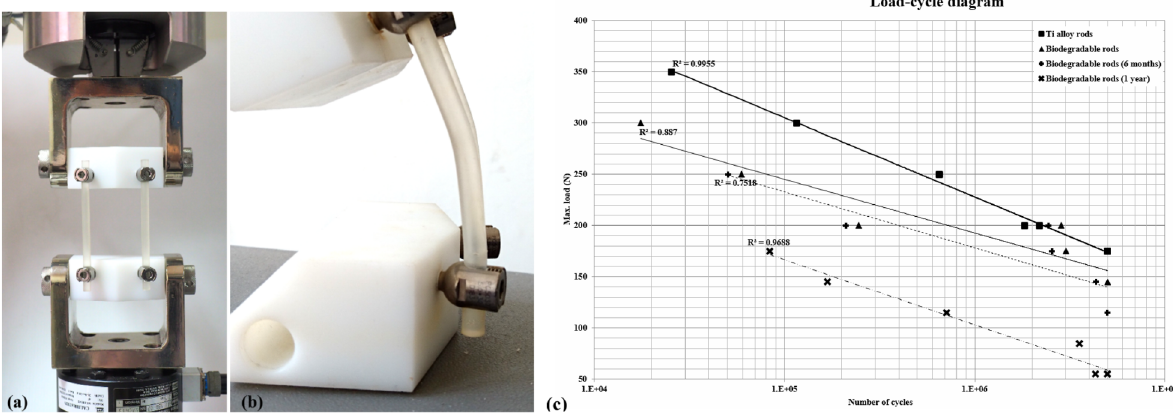
Fig 3. Safety testing according to ASTM Standard F1717-96. a) photo of testing sample, b) the failure mode for biodegradable rods (plastic deformation), c) axial compression bendingfatigue curves for CB PROT II with metal rods, biodegradable rods, and rods degraded for 1